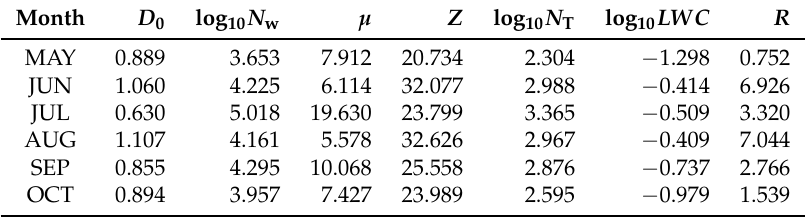
Table 2. Mean DSD parameters and integral rain parameters of the representative DSDs in each month.